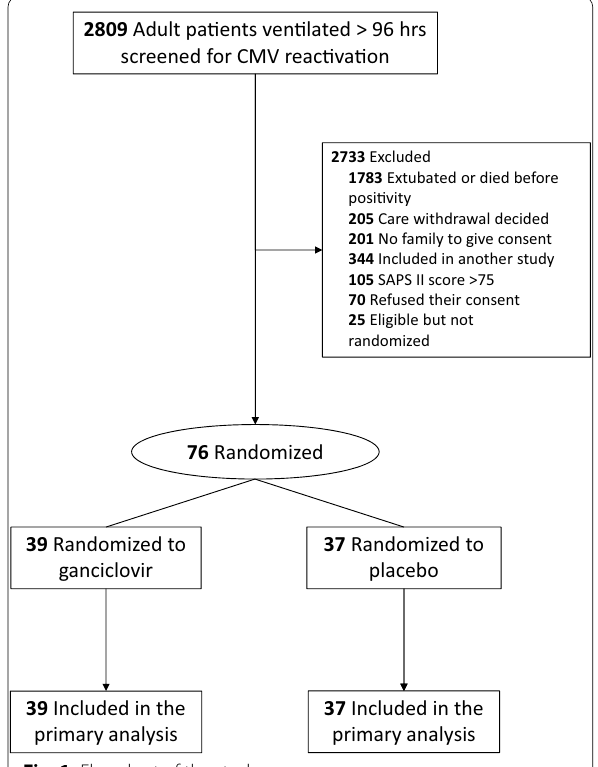
Fig. 1 Flowchart of the